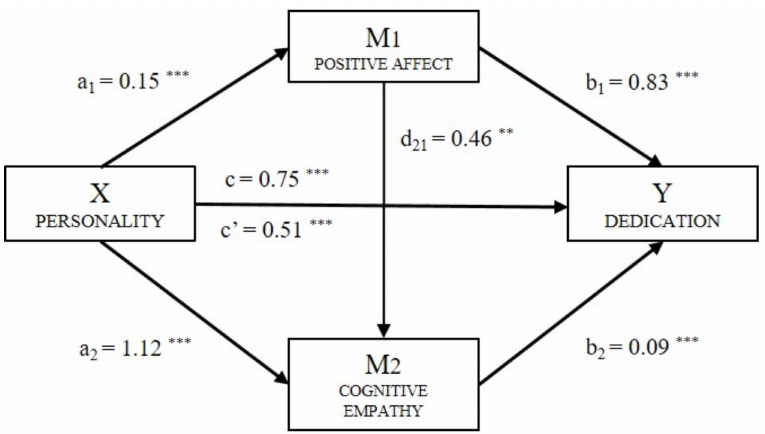
Figure 3. Multiple mediation model of positive affect and cognitive empathy on the relationship between personality and Dedication (Note. ** p < 0.01, *** p < 0.001).